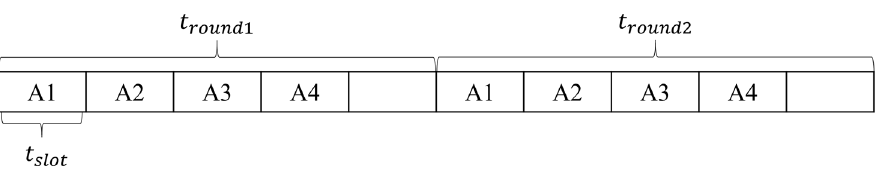
Table 1. The experimental positioning RMSEs.